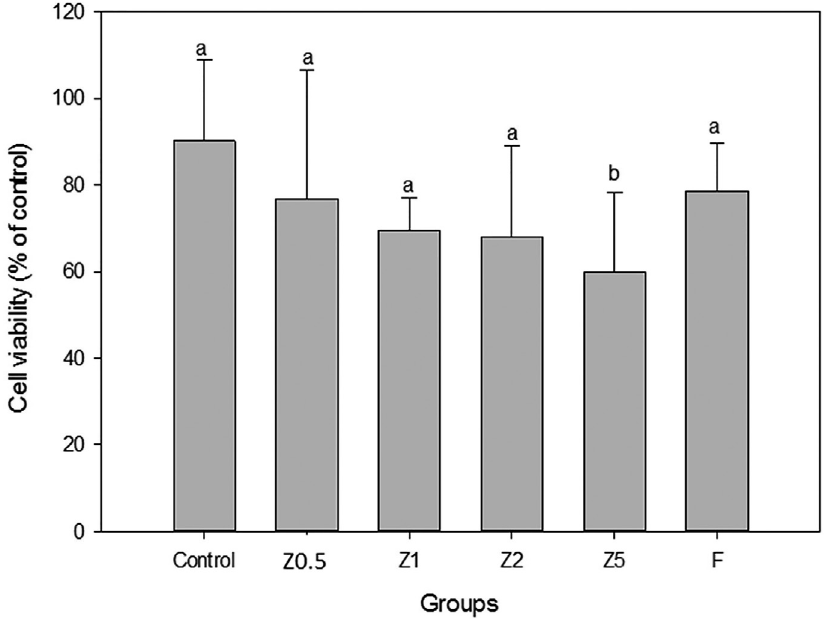
Figure 4- Cytotoxic effects on 929 fibroblast cells after exposure to TFMs